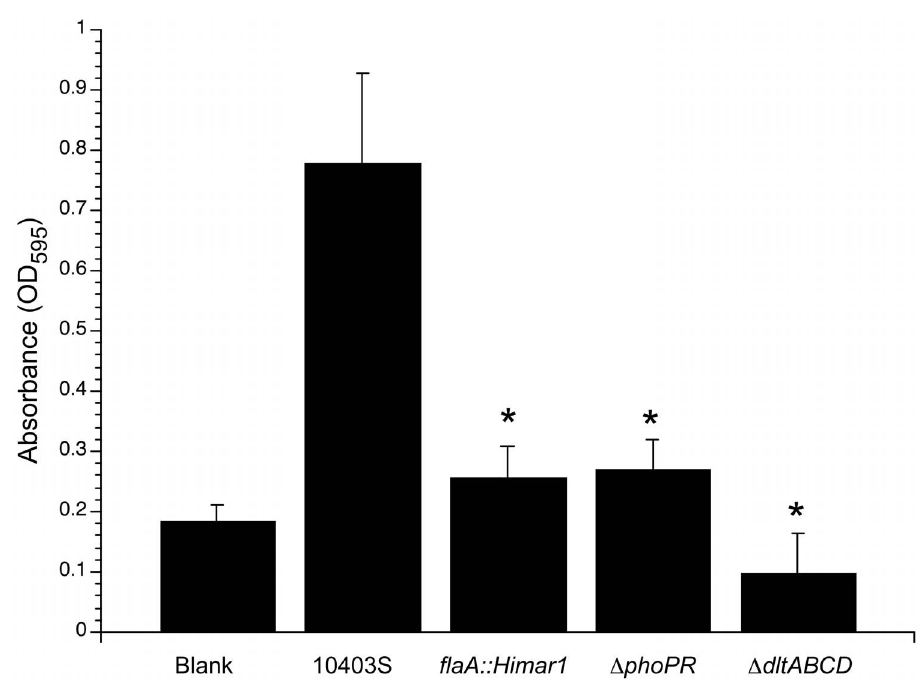
Fig. 3. Biofilm formation by D phoPR and D dltABCD L. monocytogenes . Bacterial strains were inoculated into TSBYE media in 96-well plates and grown at 35 ˚ C for 24 hours. Cultures were then diluted 1:10 into fresh HTM media with 3% glucose and 0.1 mg/mL each cysteine and methionine in new 96-well PVC microtiter plates. Plates were incubated at 35 ˚ C for 96 hours, rinsed with dH 2 O using a semi-automated cell washer, stained with crystal violet, rinsed with acetic acid and the OD 595 ¡ SD determined using a spectrophotometer. The data presented are representative of three independent experiments. *, p , 0.05 (One-way ANOVA test).